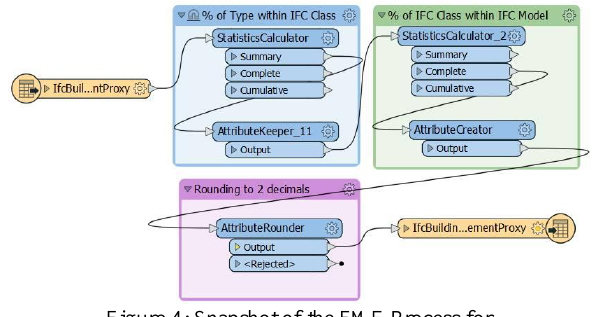
Figure 4: Snapshot of the FME Process for IfcBuildingElementProxy